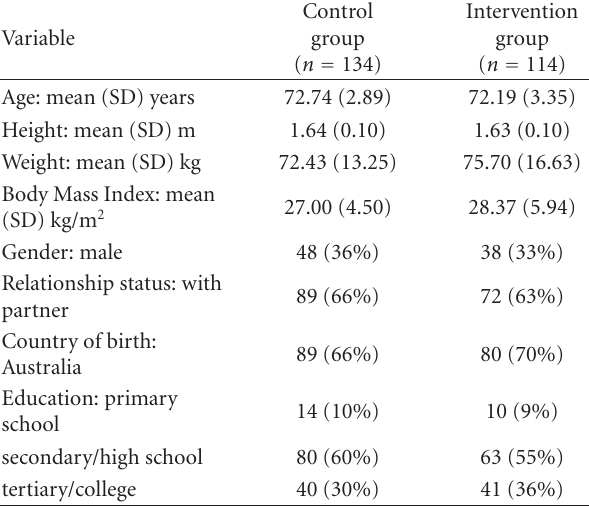
Table 1: Demographic profile of PANS participants and